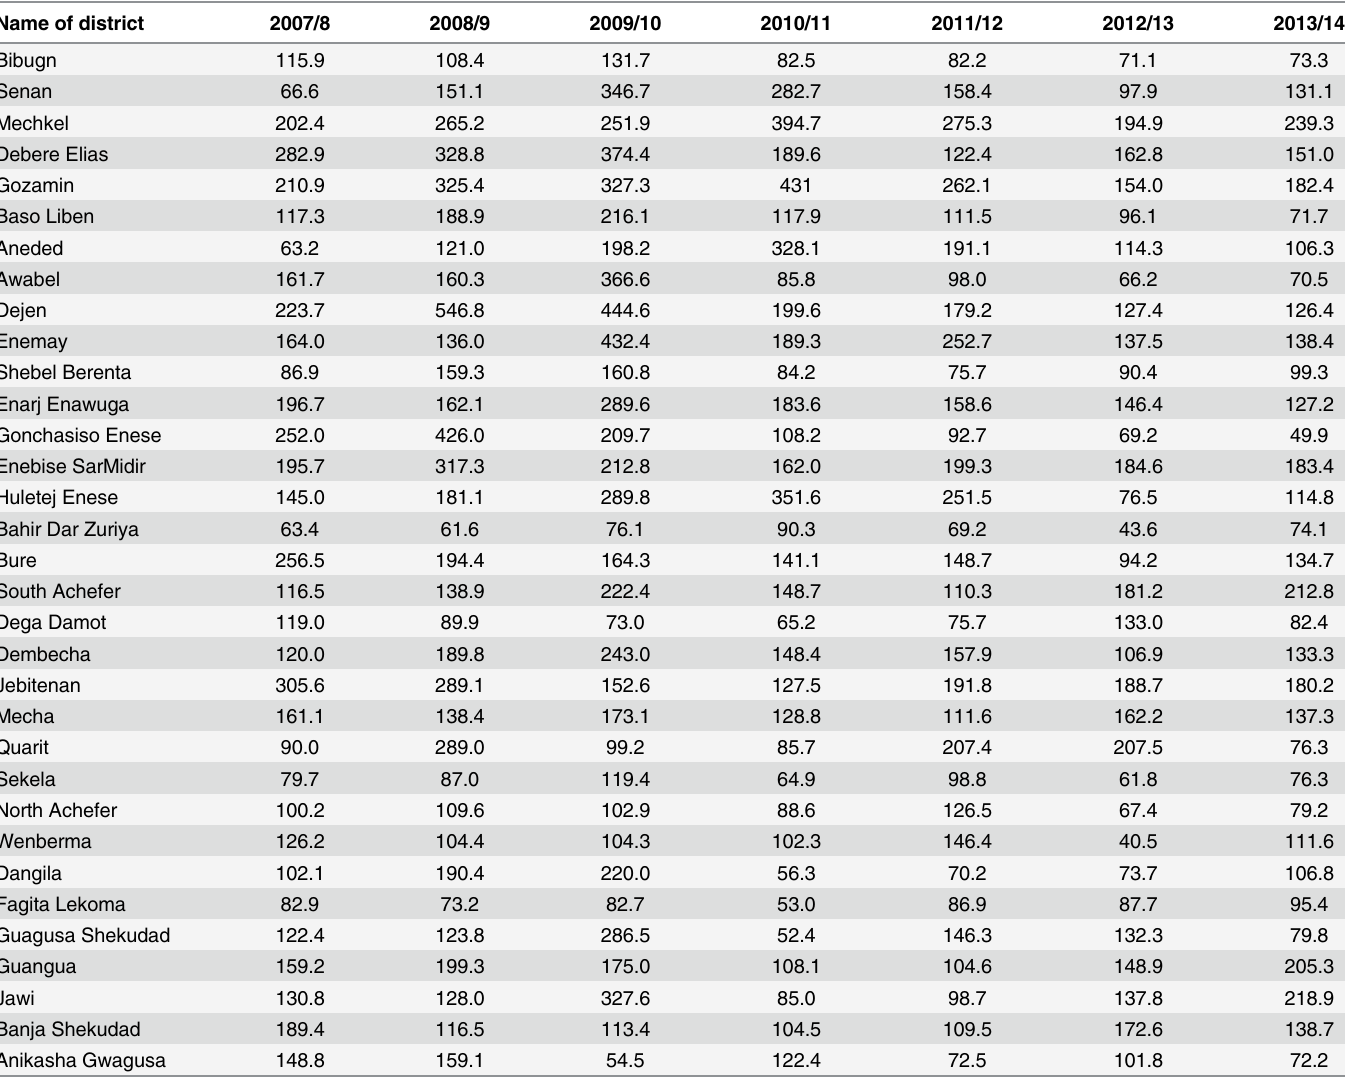
Table 1. Annual childhood diarrhea incidence rate at the district level in northwest Ethiopia between 1 July 2007 and 30 June